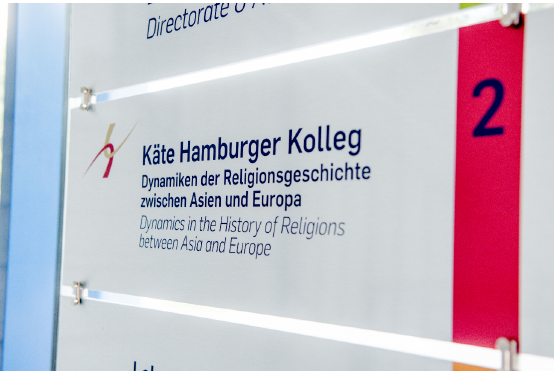
Figure 1 The Käte Hamburger Kolleg “Dynamics in the History of Religions” has been hosted by the Center of Religious Studies, Ruhr-Universität Bochum, for 14